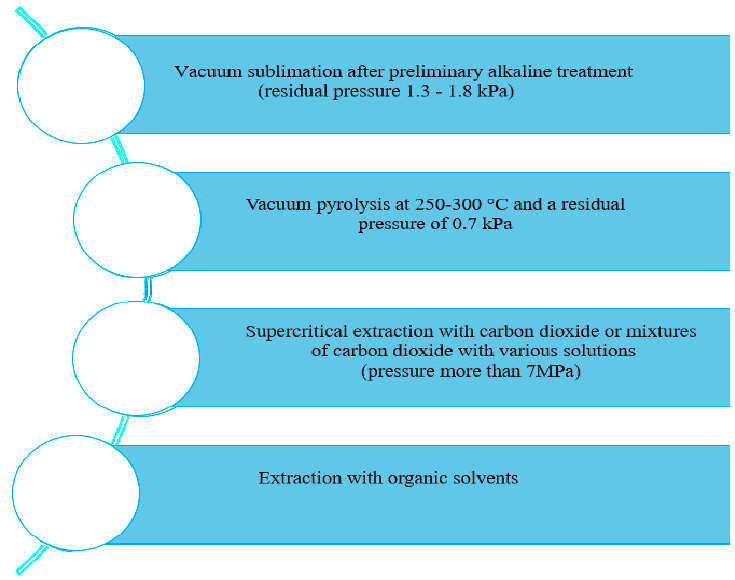
Figure 2. General methods of obtaining betulin.